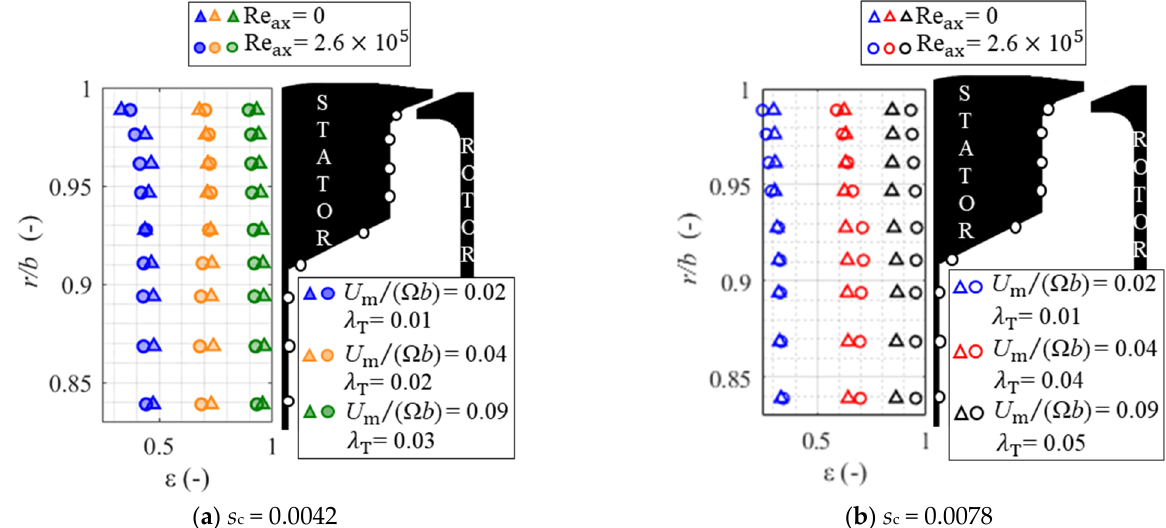
Figure 6. Radial distribution of sealing effectiveness under different conditions of purge supply and annulus flow at Re ∅ = 1.5 × 10 6 for ( a ) s c = 0.0042 and ( b ) s c = 0.0078.